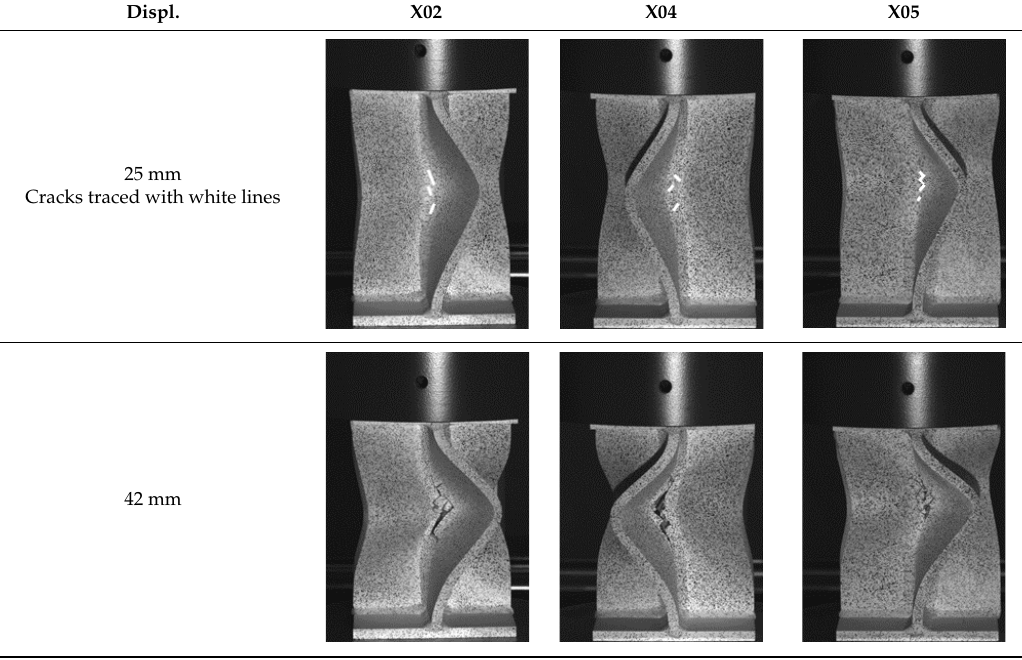
25 mm Cracks traced with white lines